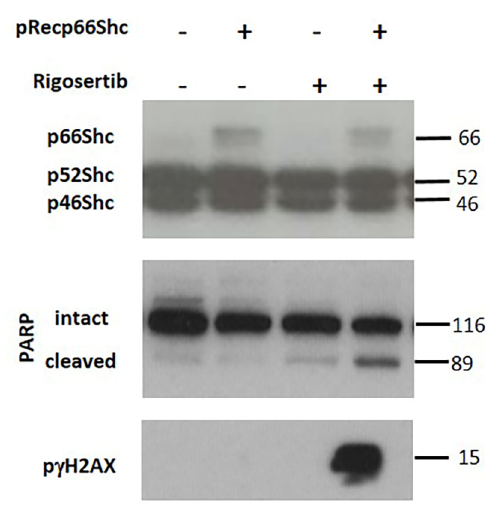
γ H2AX phosphorylation ( A ) and PARP cleavage ( B ) in MCF7, PC3 and DU-145 cells. Rigosertib was applied for 18 h at a concentration of 50 µM). Numbers on top of the blot indicate the fold change in protein phosphorylation upon Rigosertib treatment (normalized to loading control) relative to DMSO (solvent) treated control samples. All experiments have been repeated at least three times with consistent results. A representative blot is shown.